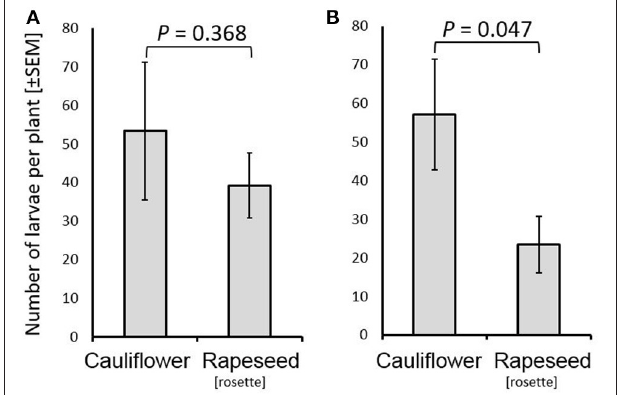
FIGURE 1 | Number of Contarinia nasturtii larvae on cauliflower and rapeseed (rosette) in a no-choice assay (A), and on cauliflower and rapeseed (rosette) in a two-choice assay (B) . Larval presence on the two host types was compared by Mann-Whitney tests for arcsine-transformed data. P -values are displayed over each graph. n = 6 for each choice type. Fifteen females were released in each